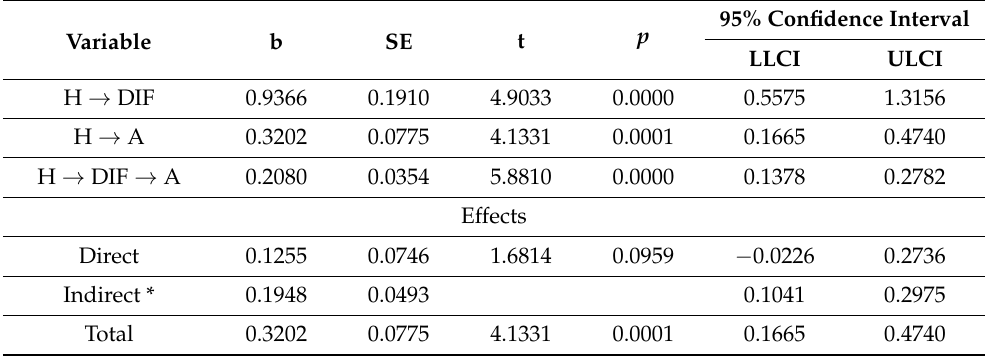
Table 7. Mediation analysis of difficulty identifying feelings (DIF) on hostility (H) – anger (A) relationship.